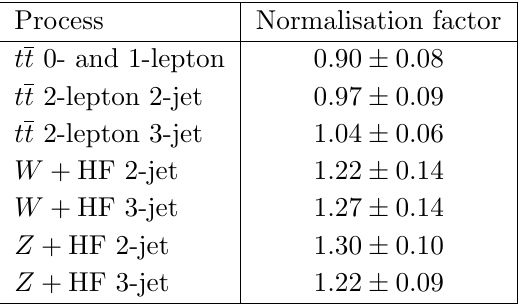
Table 10 . Factors applied to the nominal normalisations of the tt , W +HF and Z +HF backgrounds, as obtained from the global (cid:12)t to the 13 TeV data for the nominal multivariate analysis, used to extract the Higgs boson signal. The errors include the statistical and systematic